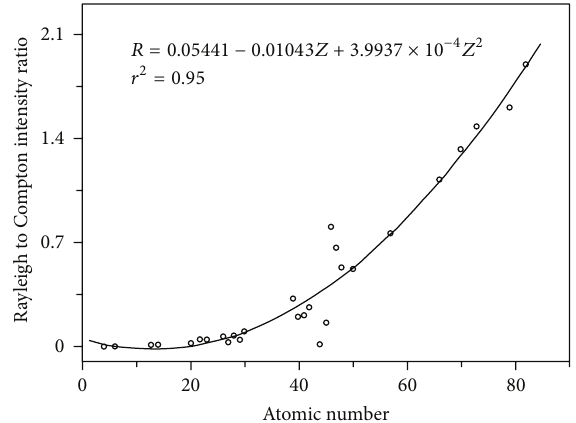
Figure 6: Rayleigh to Compton scattered intensity ratio as a function of atomic